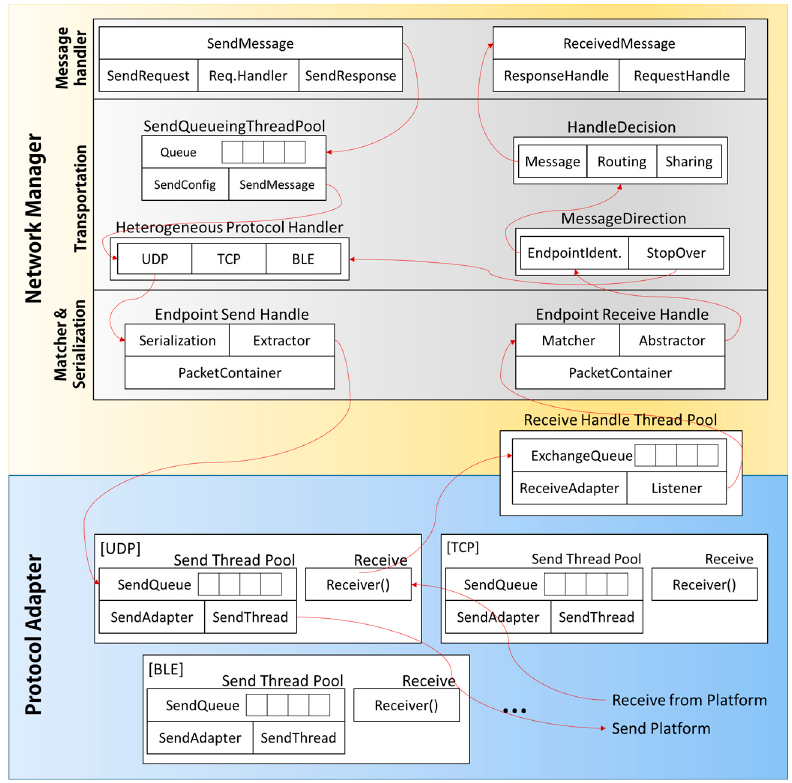
Figure 5. Connectivity module structure and flow.